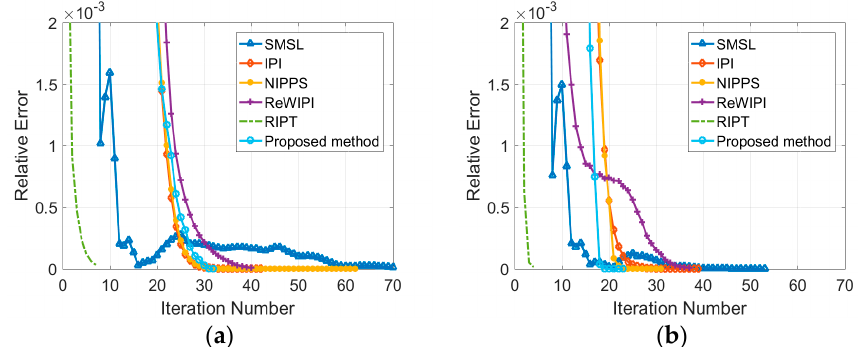
Figure 18. Illustration of the convergence rates of the methods based on low-rank recovery. ( a ) and ( b ) show the iteration curves of methods based on low-rank recovery in Sequences 1 and 2.